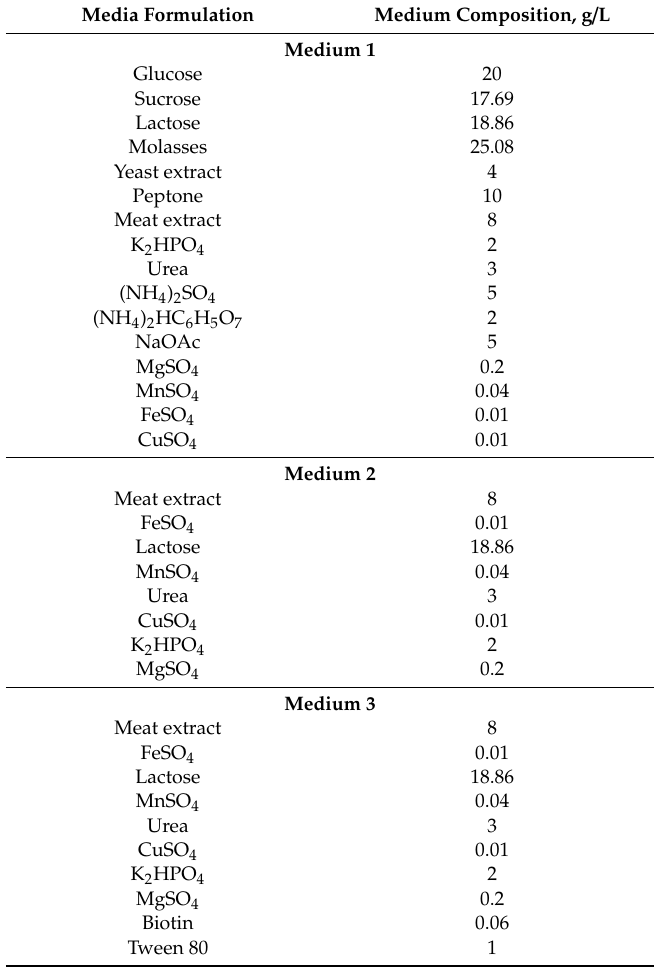
Table 11. Media formulation to validate the e ff ects of significant variables on tryptophan production by P. acidilactici TP −